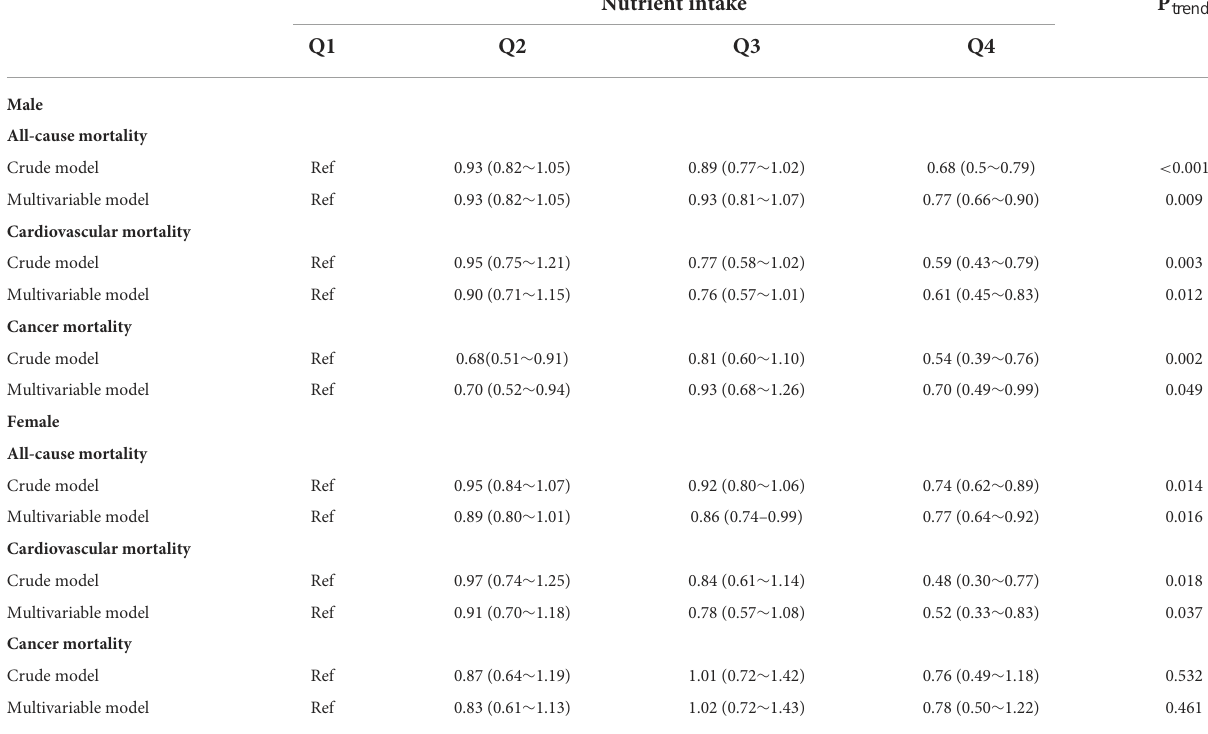
TABLE 2 Hazard ratio ( HRs ) and 95% CIs for all-cause and cause-specific mortality according to Quintiles of dietary